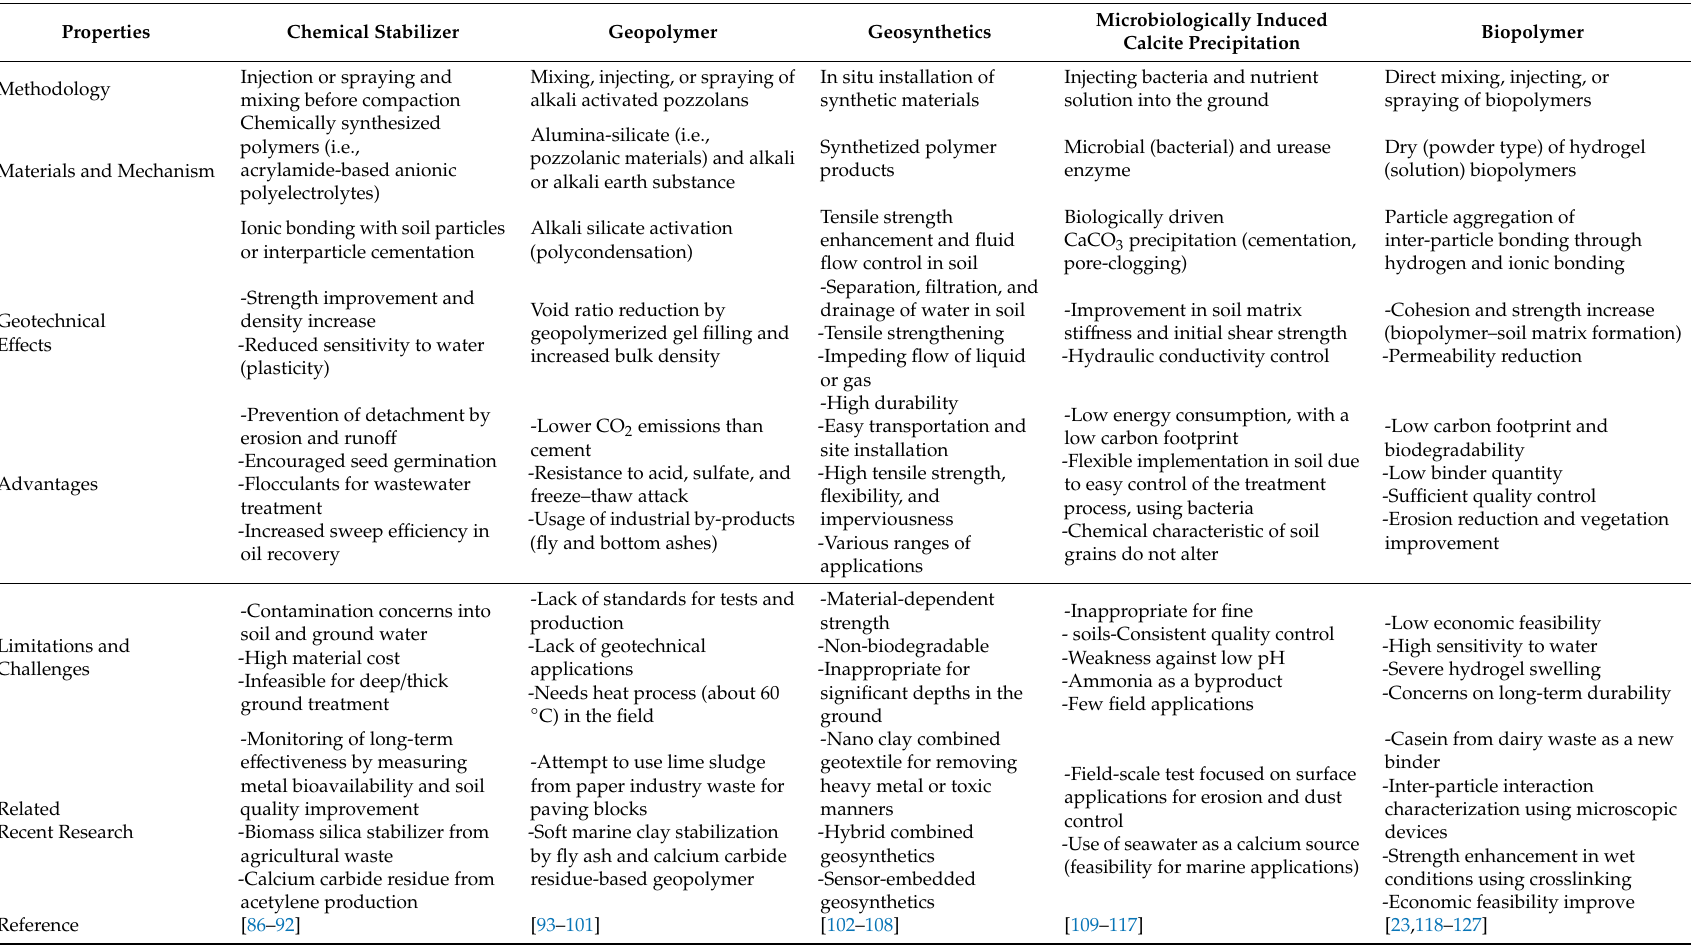
Table 2. State-of-the-art attempts to reduce cement usage in geotechnical